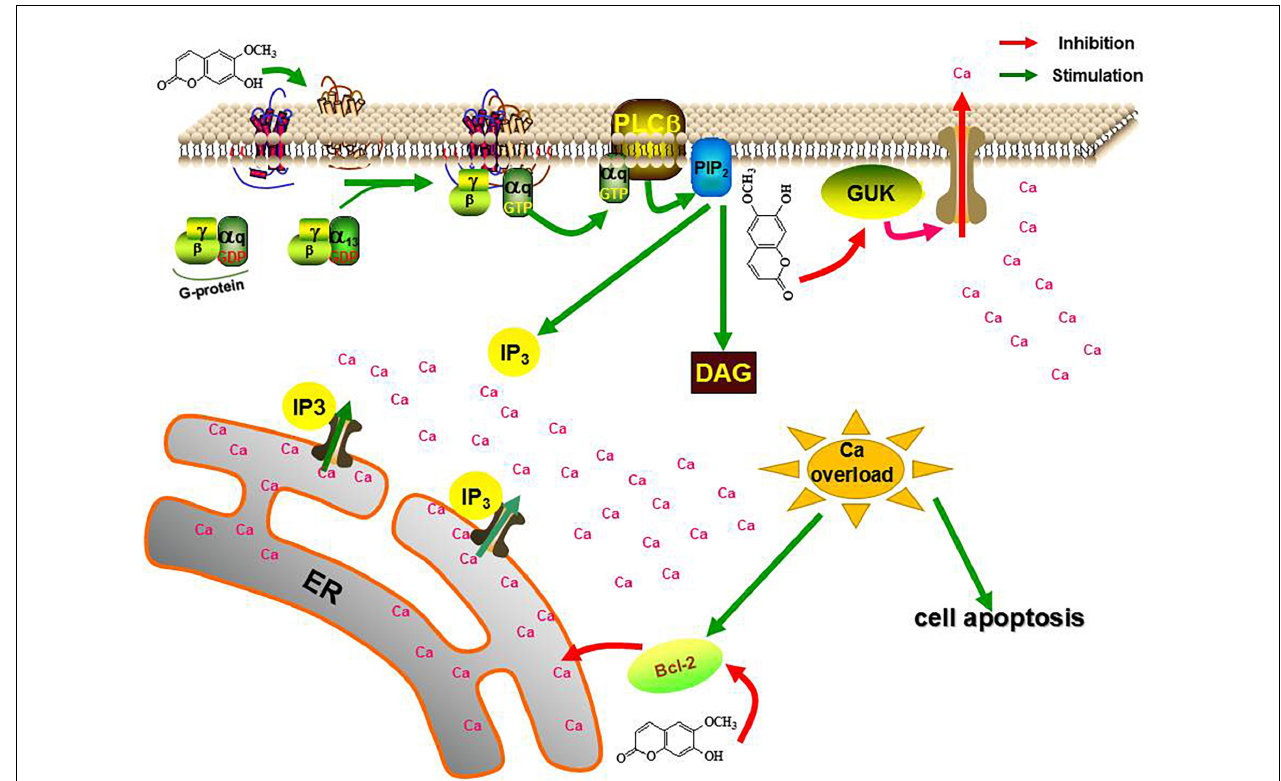
FIGURE 13 | The role of TcGPCR , TcBAG and TcGUK on the acaricidal mechanism of scopoletin. PLC β , phospholipase C β ; PIP 2 , phosphatidylinositol bisphosphate; DAG, diacylglycerol; IP 3 , inositol trisphosphate; ER, endoplasmic